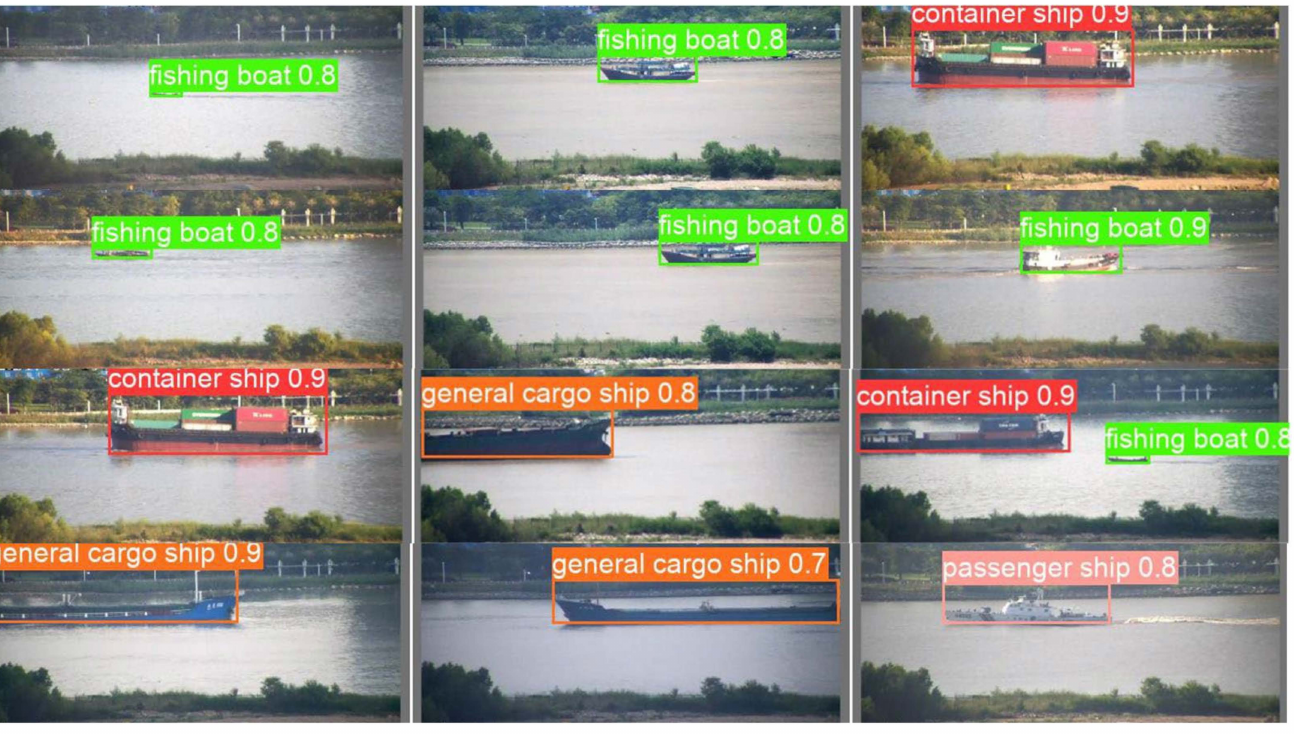
Figure 17. Visualization of test results.